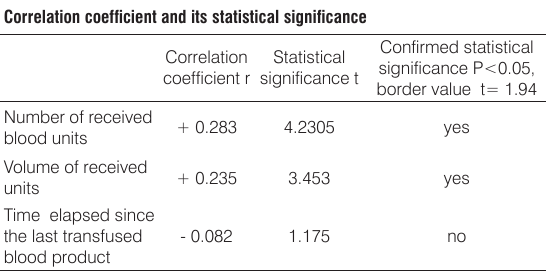
Table 2. Correlation coefficient between degree of sensitization and presented